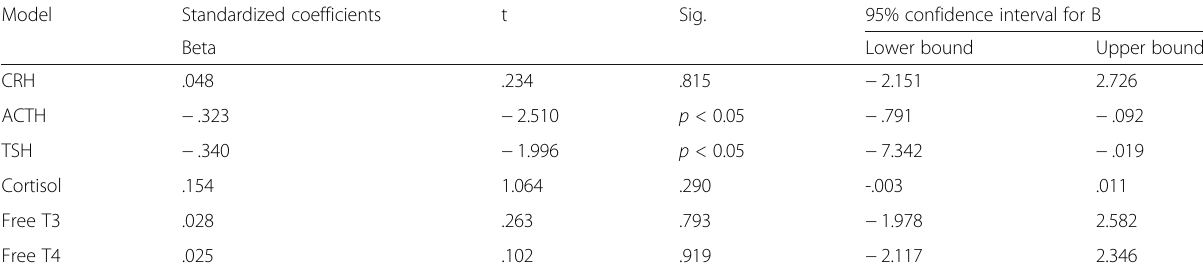
Table 6 The regression analysis for MoCA in patients with CTTH